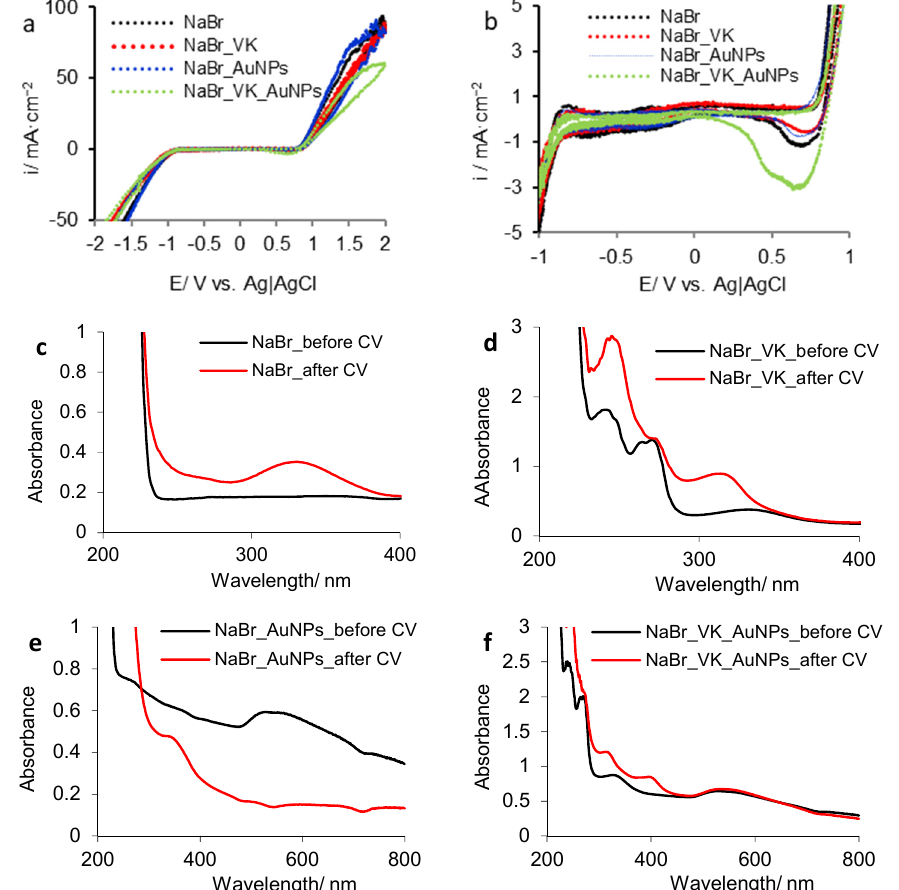
Figure 5. Cyclic voltammograms recorded on platinum electrode in 0.1 mol · L − 1 NaBr blank solution and 0.1 mol · L − 1 NaBr solution containing 6.65 × 10 − 5 mol · L − 1 VK, in the absence and presence of 75 mg · L − 1 AuNPs ( a ) and their details for low current densities ( b ); UV-Vis spectra collected before and after CV; ( c )—in NaBr blank solution (NaBr); ( d )—in NaBr solution containing VK (NaBr–VK);